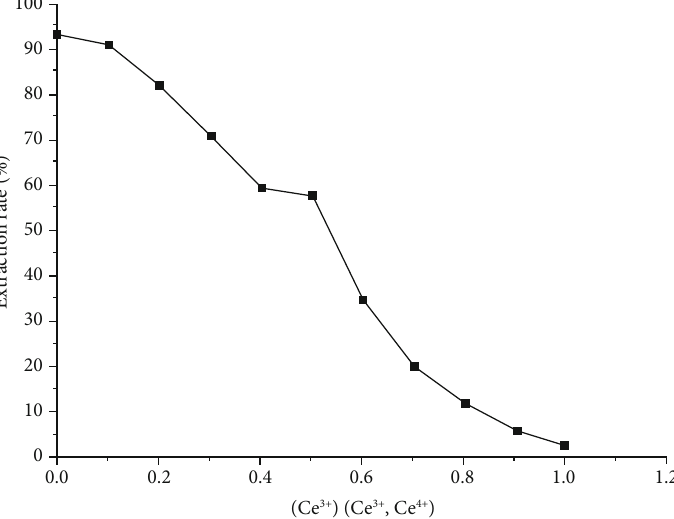
Figure 8: [Ce 3+ ]/[Ce 3+ , Ce 4+ ] in fl uence on extraction.